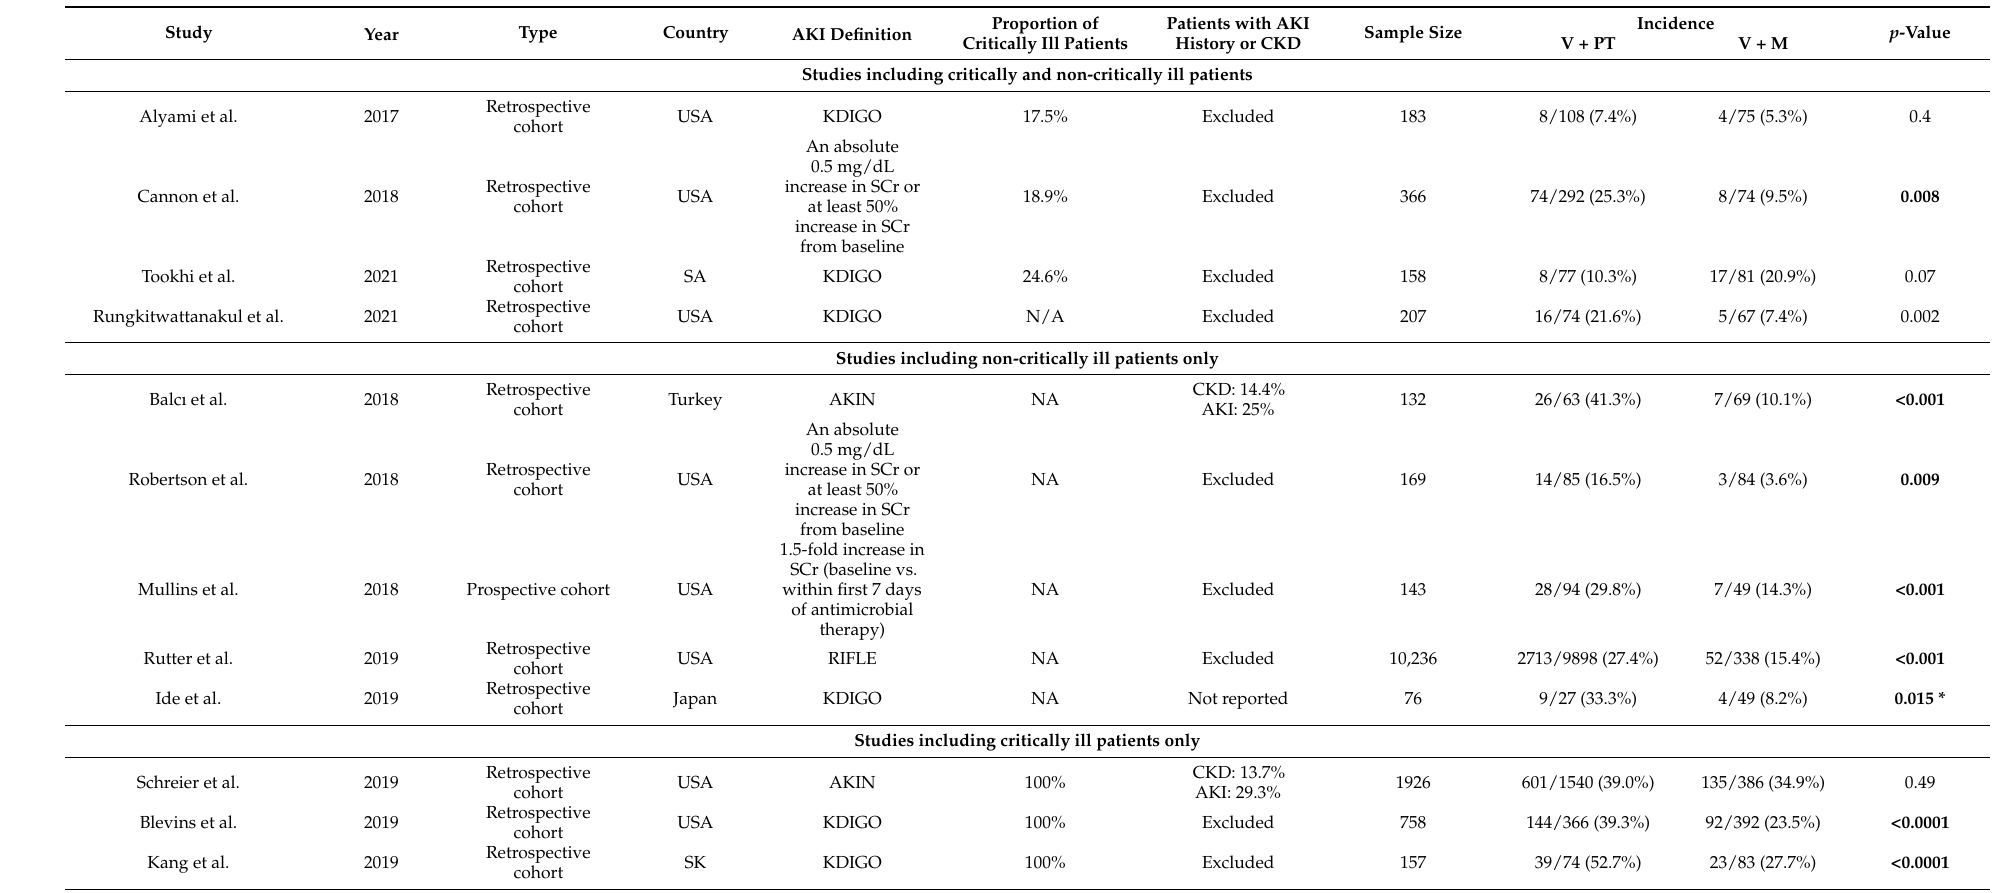
Table 1. Studies that were included in the systematic review and